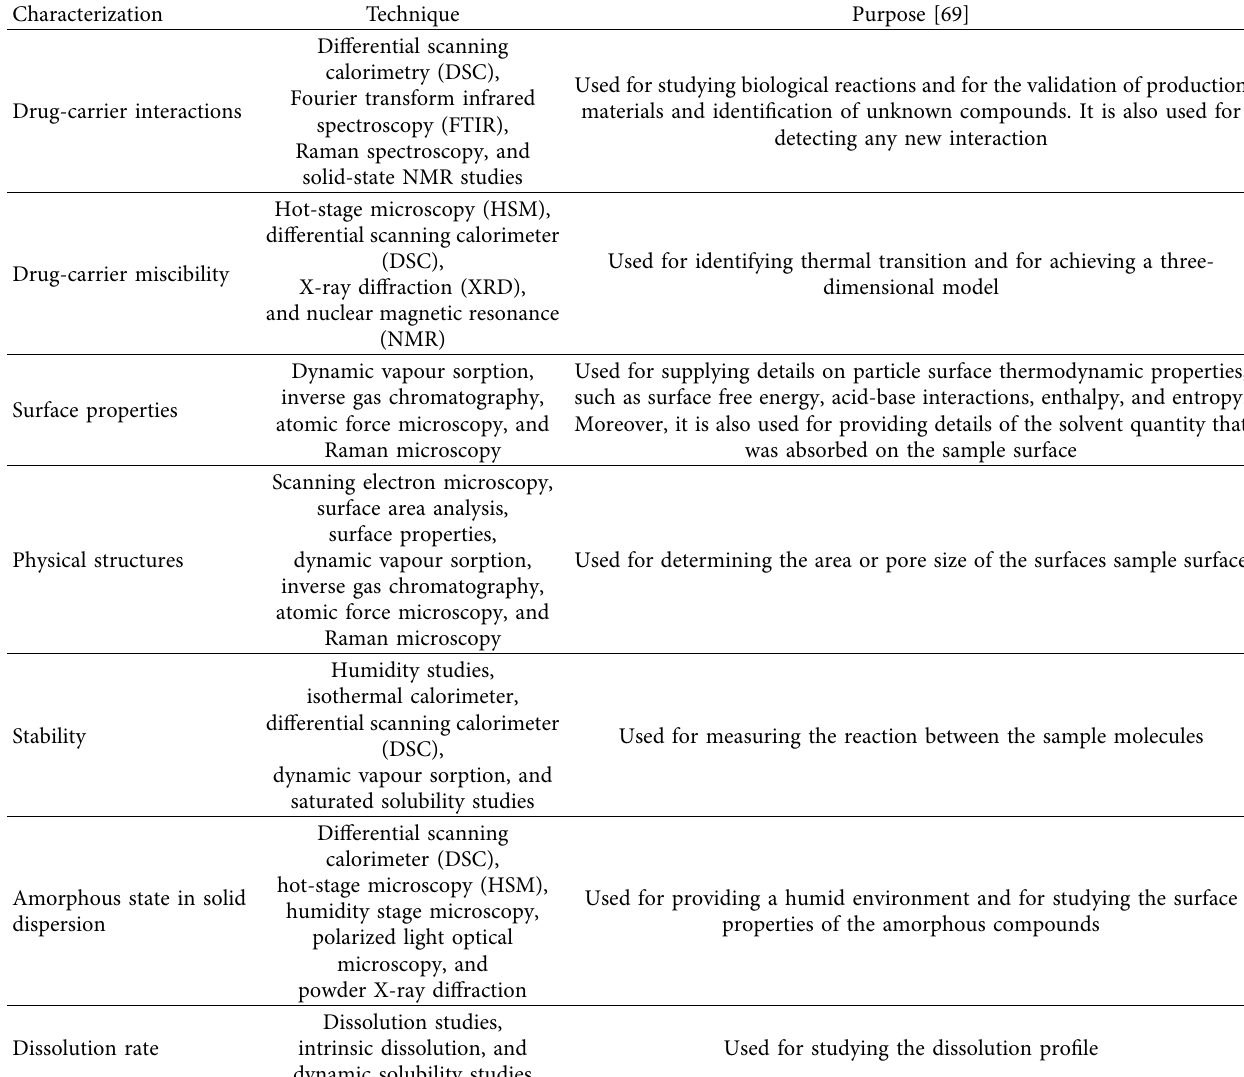
Table 7: Different characterization methods to assess solid dispersion